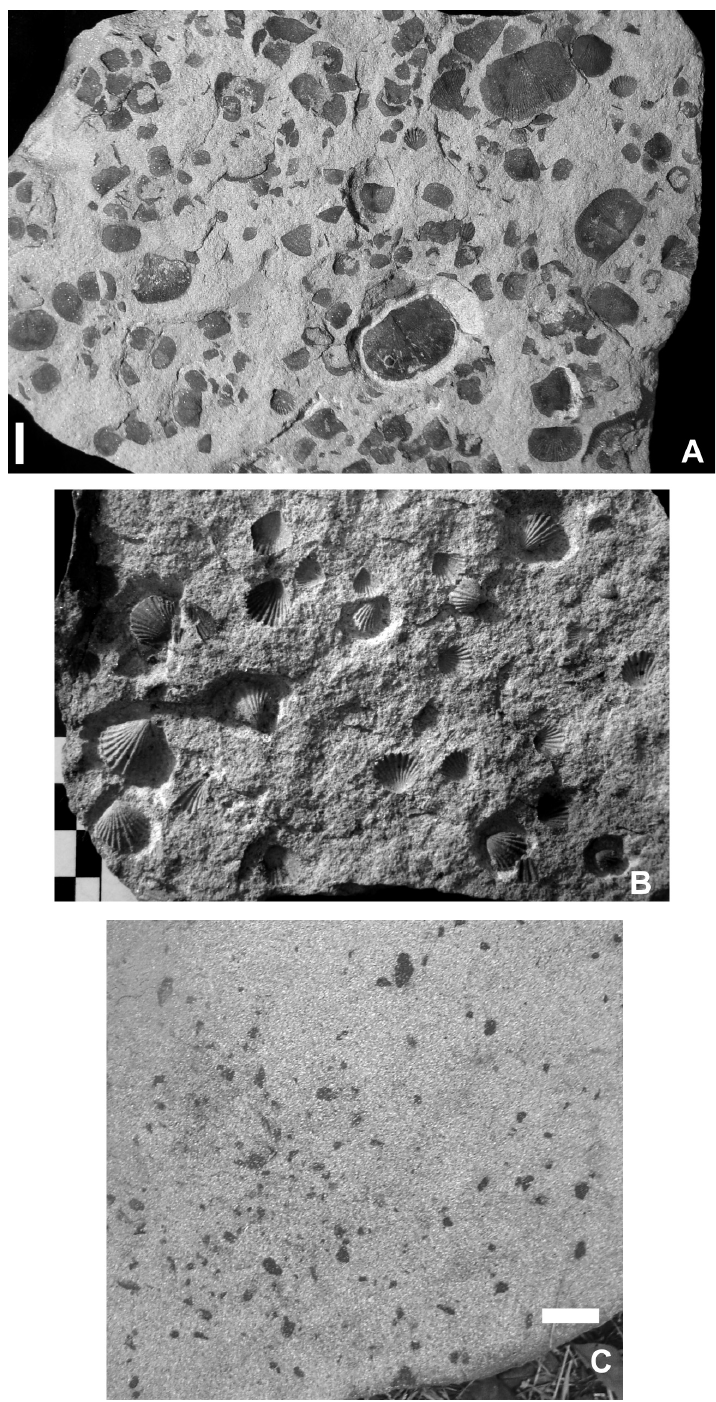
Fig. 3 – (A) Marine megainvertebrate assemblage typical of the distal mouth-bar deposits, dominated by Pleurochonetes comstocki . (B) Ma- rine megainvertebrate assemblage of the delta-front sandstone lobes with hummocky cross-stratification, showing the dominance of terebratulid brachiopods. (C) Rhythmic sand-silt couplets with abundant plant debris ( Spongiophyton ) and mica. A, B and C are from Passagem Member, Oiti region, near Pimenteiras, Piauí State. Bar scale = 1